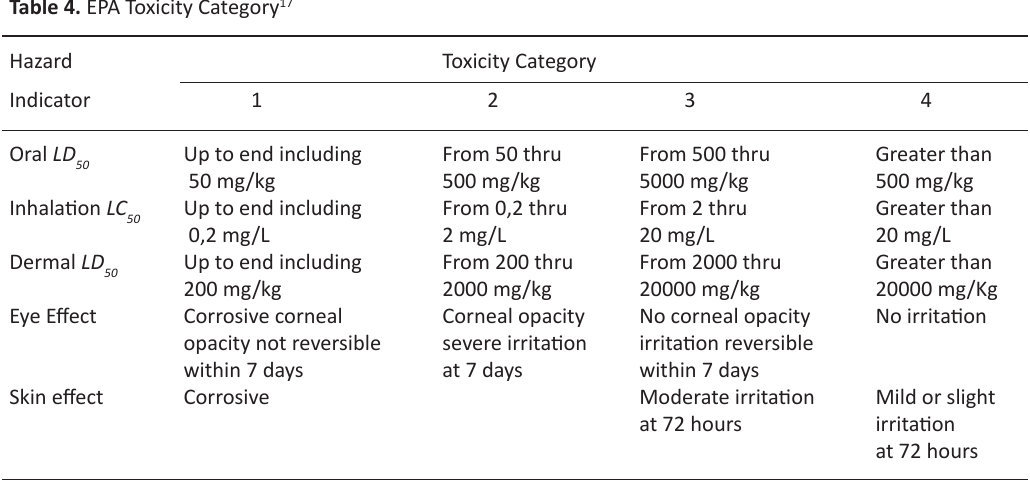
Table 4. EPA Toxicity Category 17